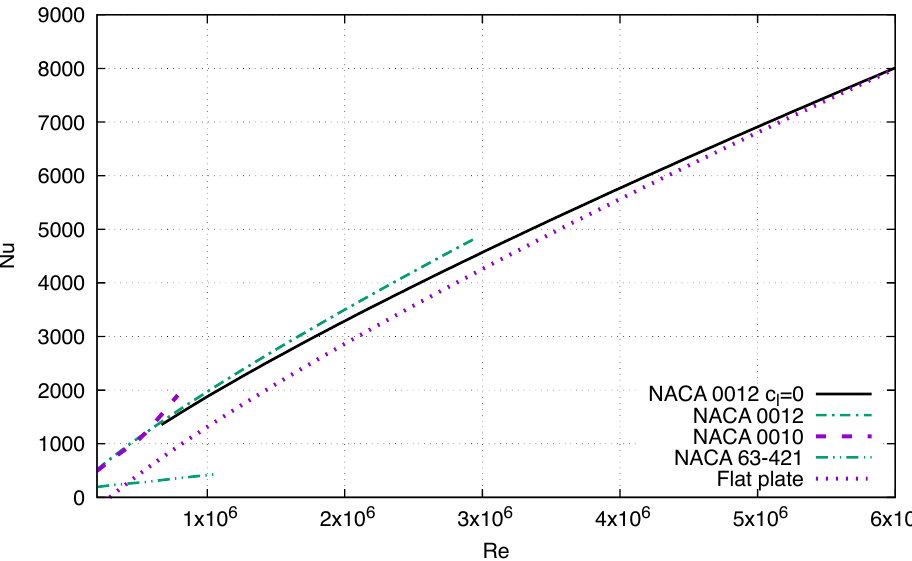
Figure 13. Nu as a function of Re : comparison between the Equation (15) results for the NACA 0012 airfoil at c l = 0 and the correlation results at α = 0 ◦ for the NACA 0012 [15], the NACA 0010 [36], the NACA 63-421 [38], and the flat plate Nu = (( 0.037 Re 0.8 − 871 ) Pr 1/3